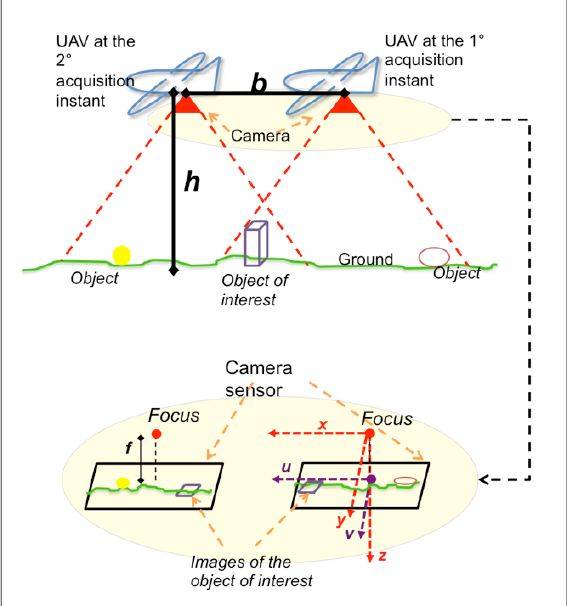
Figure 1. Geometry of the problem.